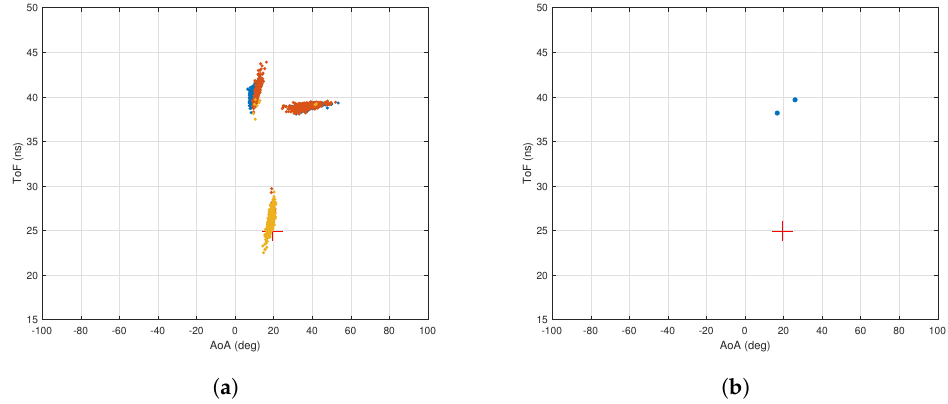
Figure 5. Simulation with ambient noise. ( a ) performance of MMP with SNR = 35 dB for 1000 runs. The RMSEs for AoA and ToF are 2.34 deg and 6.24 ns and the bias for AoA ToF are − 1.53 deg and − 0.49 ns. Simulation time is 0.79 s; ( b ) performance of 2D MUSIC with SNR = 35 dB for 1000 runs. The RMSEs for AoA and ToF are 2.60 deg and 13.69 ns and the biases for AoA and ToF are − 1.97 deg and 16.95 ns. Simulation time is 152.21 s.